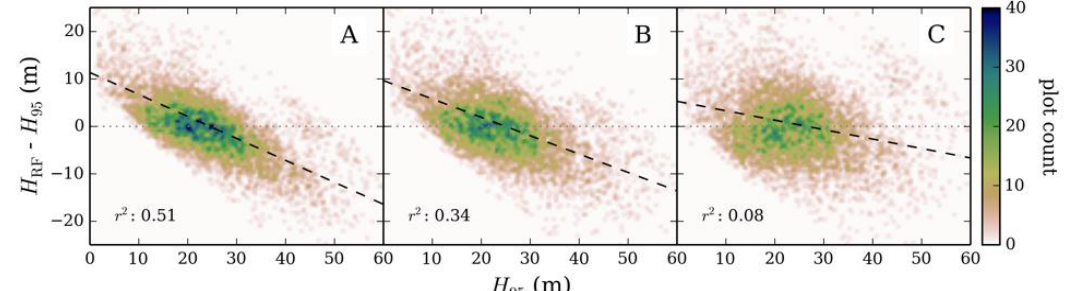
Figure 3. ALS derived canopy height ( H 95 ) compared to model residual error for random forest models ( H RF ); constructed using 5000 ALS plots of untransformed response data ( A ), 5000 ALS plots where the response variable was resampled to a uniform distribution ( B ), and subtraction of systematic error from modeled canopy height ( C ). The coefficient of determination values ( r 2 ) were calculated from a linear regression of measured canopy height and model residuals.